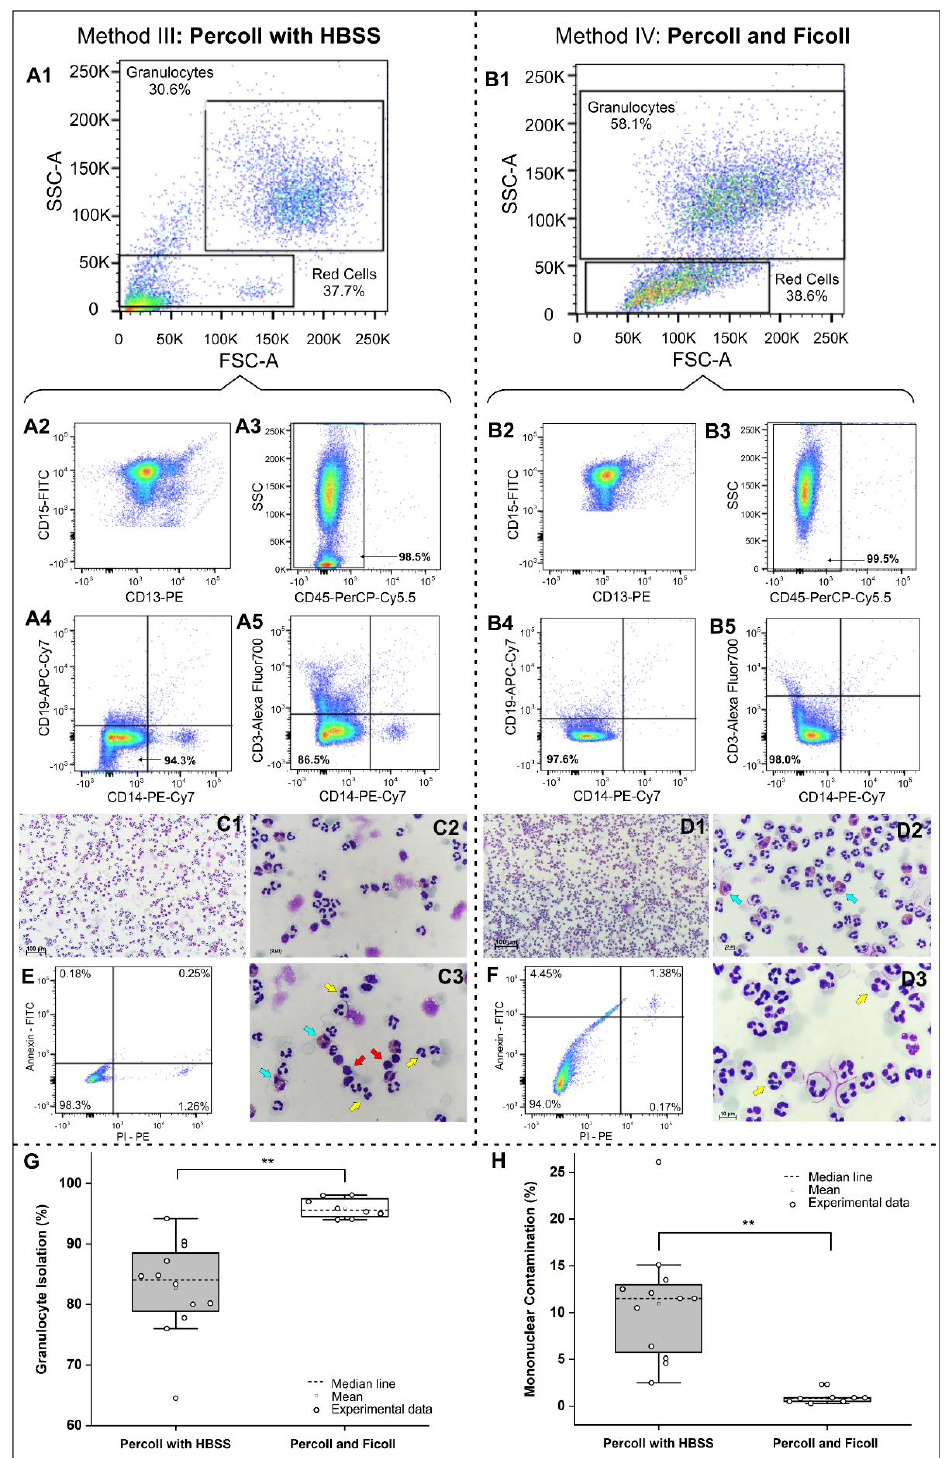
Figure 2. Analysis of the purity of isolated granulocytes and their morphological appearance (fast panoptic) between isolation methods III and IV. ( A1 , B1 ) Forward-scatter (FSC) vs. side-scatter (SSC) plots represent the isolated neutrophil population. Neutrophils isolated by methods III and IV were labeled with a mixture of antibodies and analyzed for the expression of ( A2 , B2 ) CD15 and CD13, ( A3 , B3 ) CD45 (as positive markers) and ( A4 , B4 ) CD19 and CD14 and ( A5 , B5 ) CD3 and CD14 (as negative markers). ( C1 – 3 , D1 – 3 ) Fast panoptic staining represents the morphological di ff erences between neutrophils (indicated by the yellow arrows), contaminants (indicated by the red arrow)